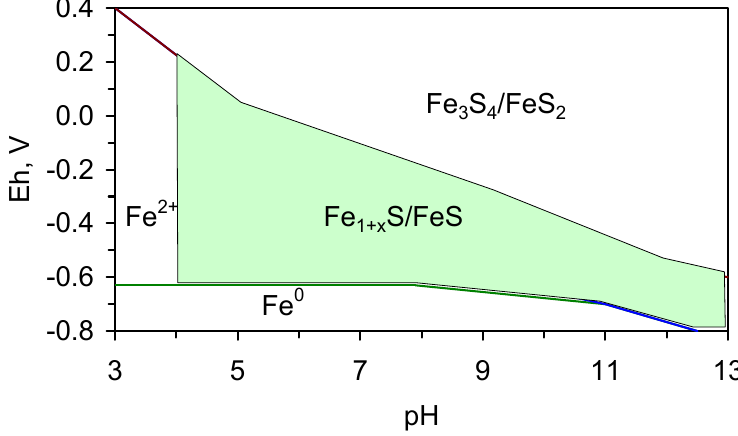
Figure 23. Pourbaix diagram showing the Eh, pH regions where the dominant stable precipitate is FeS 2 , Fe 1+ x S. Data: